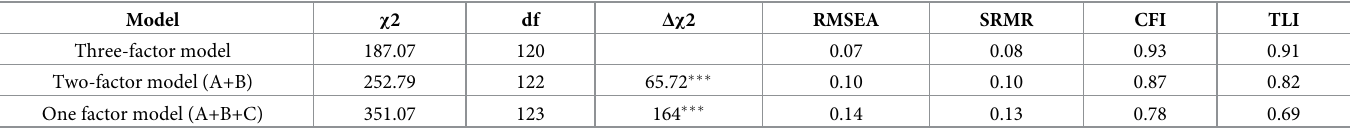
Table 1. Results of confirmatory factor analysis (N =